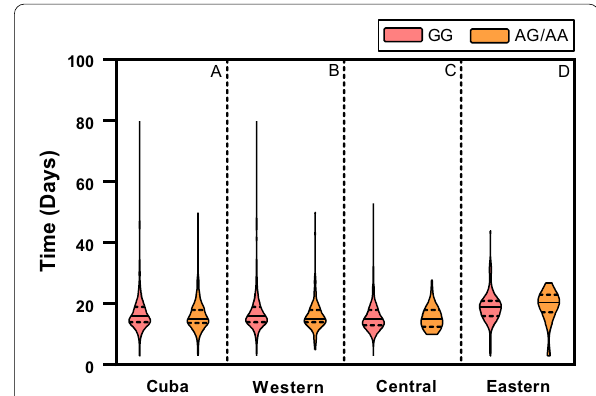
Fig. 1 Number of days from the positive RT‑PCR test for SARS CoV‑2 until hospital discharge according to TNFα 308A > G polymorphism − genotypes. Violin plots showing hospital stay as of the time of the positive RT‑PCR test in Cuba ( n 1028, included 955: GG 761, = = = AG/AA 194; missing value 7.1%) ( A ), Western region ( n 598, = = = included 541: GG 434, AG/AA 107; missing value 9.5%) = = = = ( B ), Central region ( n 310, included 306: GG 233, AG/ = = = AA 73; missing value 1.3%) ( C ) and the Eastern region ( n 120, = = = included